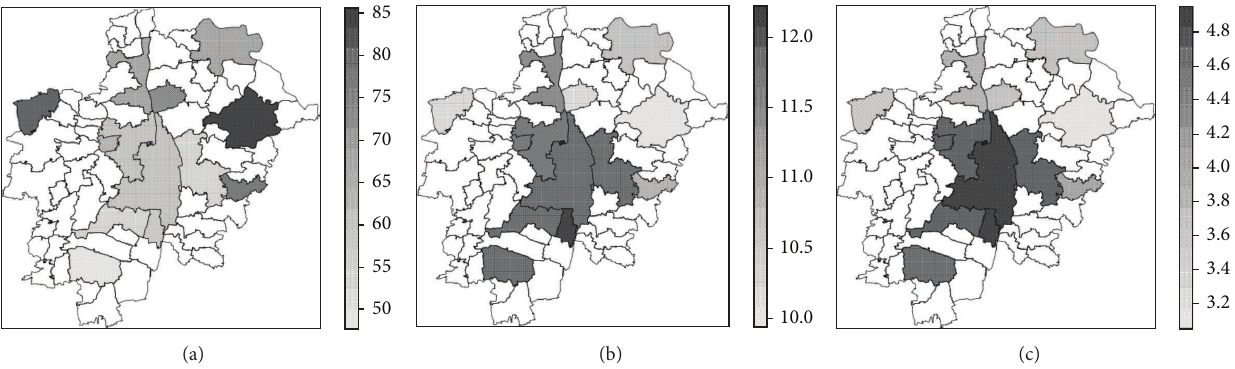
Figure 4: Values of education-related parameters; values refer only to German native subjects. (a) Percentage of subjects achieving a maximum of 11 school years, where the maximum in the sample is 17 school years (EY8 11); (b) mean years of school attendance per LU (EY MEAN); (c) mean score of the education level per LU, ranging from 0 = no school degree up to 9 = graduate degree (M.S. equivalent or higher).